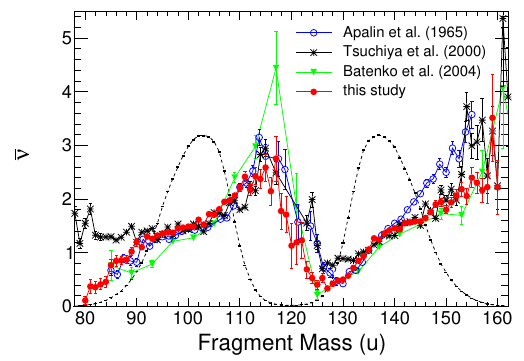
Figure 3. Average prompt neutron multiplicity per fragment as a function of the fission fragment mass. Data obtained in this study is compared to data from literature [17, 19, 20]. The dotted black line shows the shape of the fission fragment mass distribution (without absolute scale).